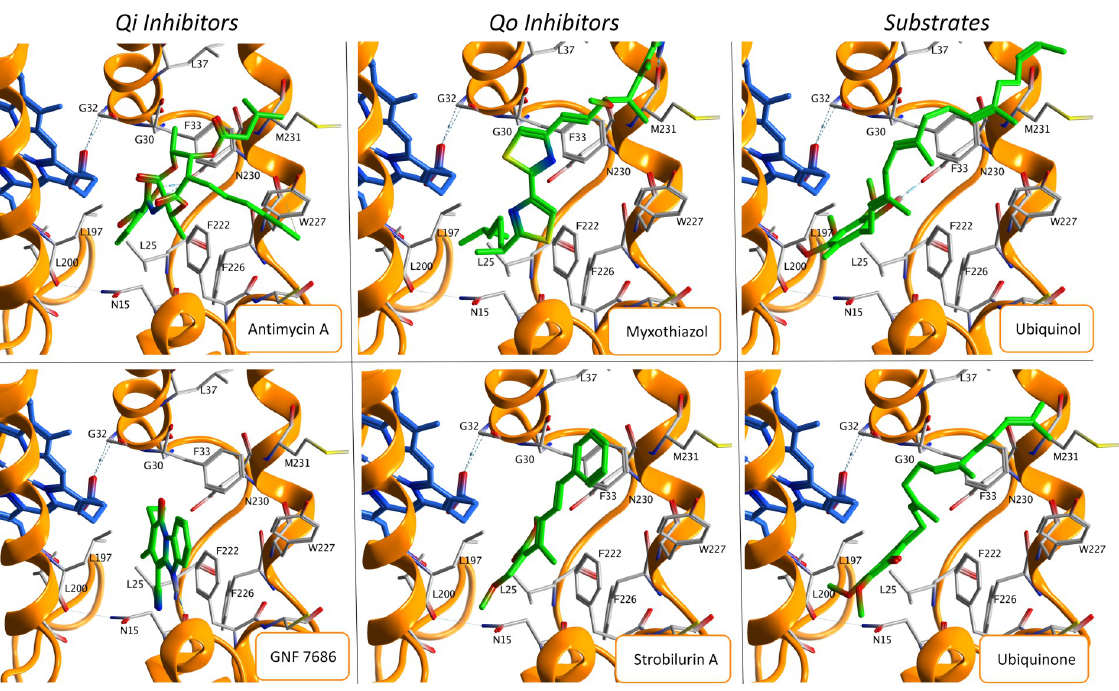
Fig 3. Best ligand centroids in terms of PLANTS scoring function of each ligand, divided in Qi inhibitors, Qo inhibitors and substrates. Each ligand is shown in green, the bH-heme molecule in blue, the cytochrome b in orange cartoon, and the main residues of the Qi pocket receptor in